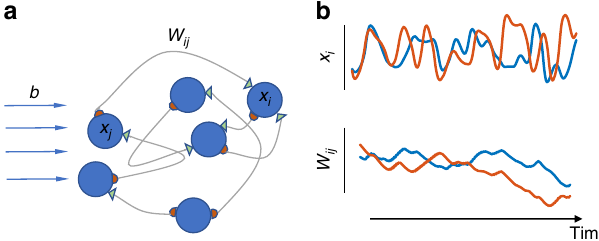
Fig. 1 Co-evolution of neural activity and connectivity. a Illustration of our modeling framework: a recurrently connected neural network, with W ij denoting the connection strength from neuron j to neuron i . The dynamic variables x i evolve by Eq. (1) and connection strengths W ij evolve by Eq. (2). An external signal b i can be added as input to each neuron i . b Two example traces of neural state dynamics ( x i ( t ); top, colors) and of connection strength dynamics ( W ij ( t ); bottom, colors) are shown. Both evolve over time, though on different timescales, and their dynamics are